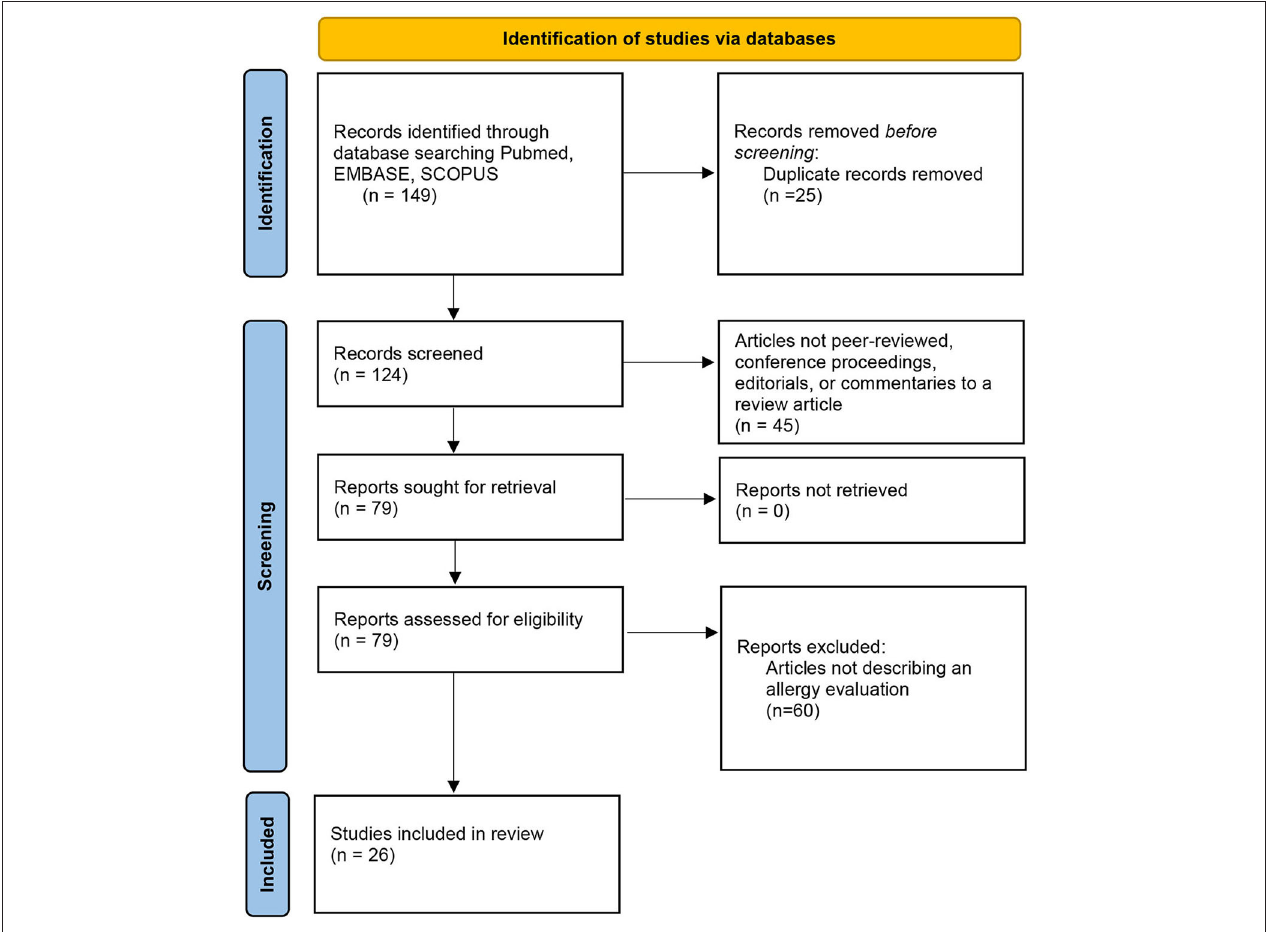
FIGURE 2 | Flow diagram for search